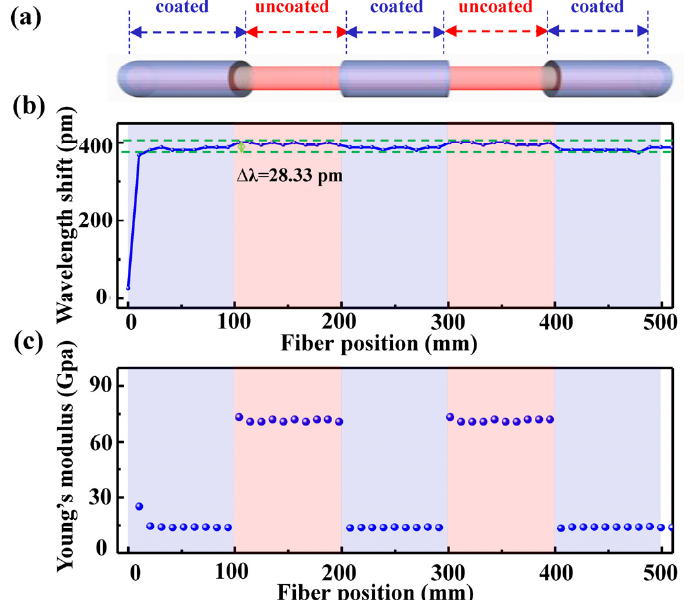
Figure 7. ( a ) Schematics diagram of the periodically coated and uncoated optical fiber, ( b ) Measured wavelength shift, and ( c ) Young’s modulus along the axis of the periodically coated and uncoated optical fiber.